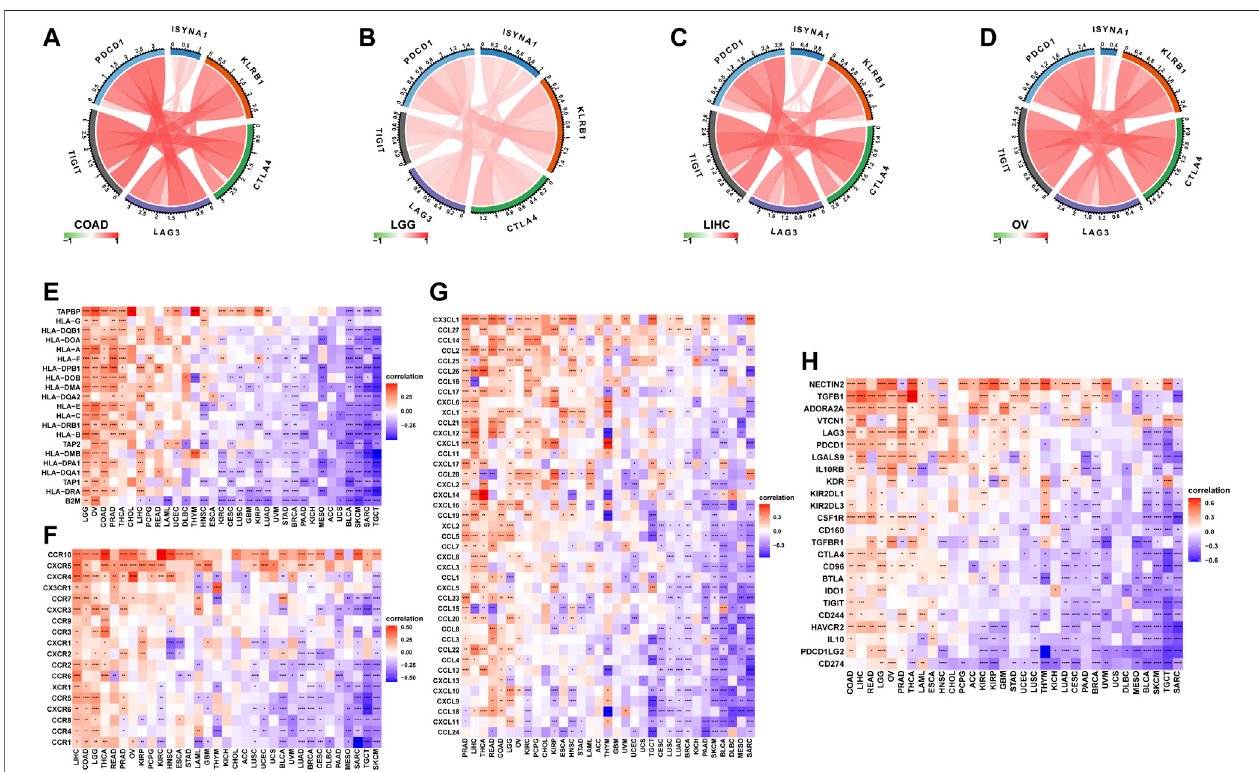
FIGURE 10 | Correlation betweenISYNA1 expressionand immunosuppressive genes. (A – D) The correlation between ISYNA1 expressionand immunecheckpoints. Red lines represent positive correlation, and blue linesrepresent negative correlation. The darkerthe color,the stronger the correlation. (E) The correlation between ISYNA1 expression and MHC genes in pan-cancer. (F) The correlation between ISYNA1 expression and chemokine receptors in pan-cancer. (G) The correlation between ISYNA1 expression and chemokines in pan-cancer. (H) The correlation between ISYNA1 expression and immunosuppressive genes in pan-cancer. Red represents positive correlation, and blue represents negative correlation. The darker the color, the stronger the correlation. * p < 0.05, ** p < 0.01, *** p < 0.001, **** p < 0.0001.